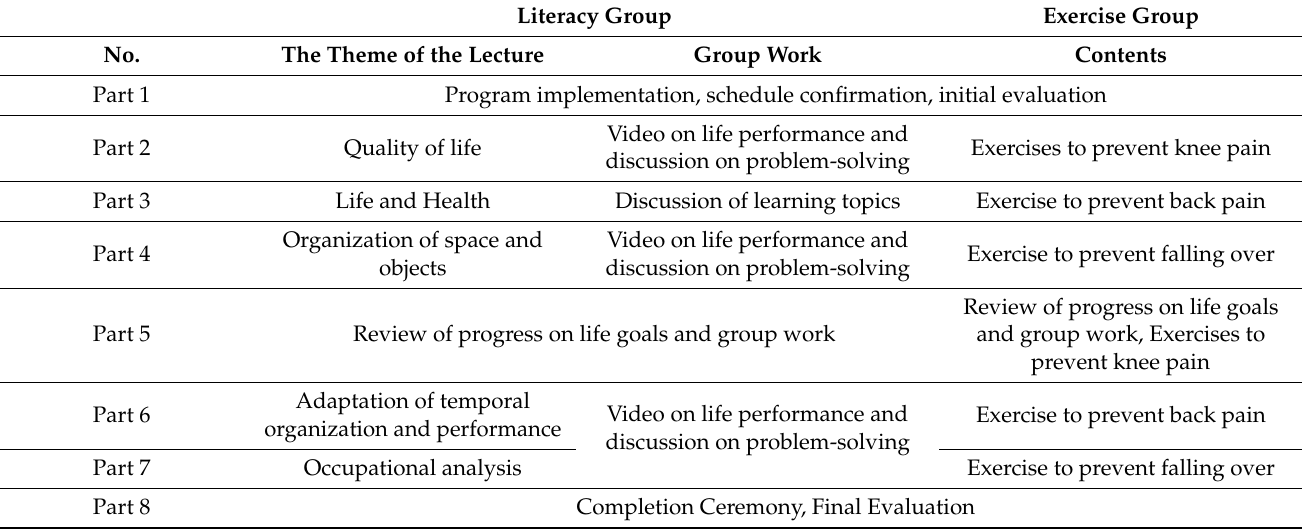
Table 1. Overall program flow of the literacy group and the exercise